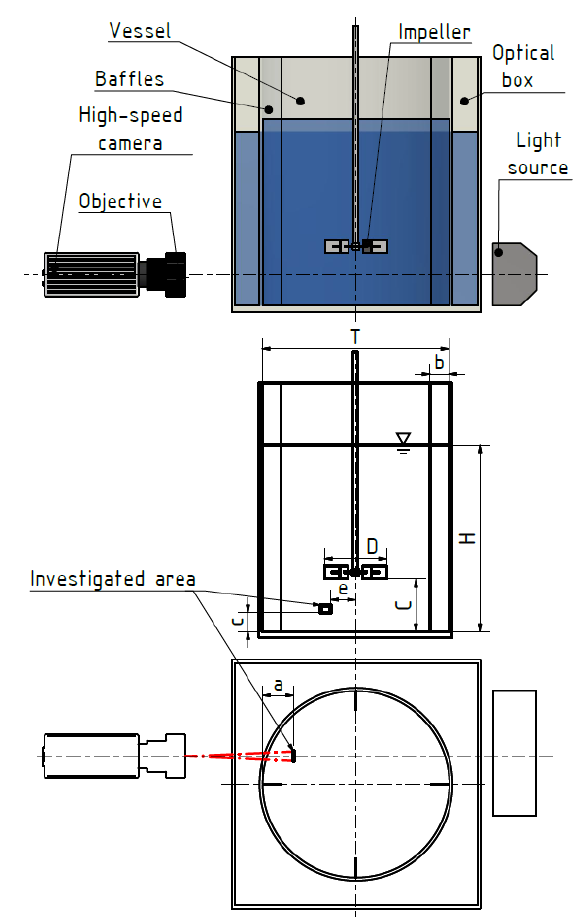
Fig. 1. Scheme of image acquisition system.